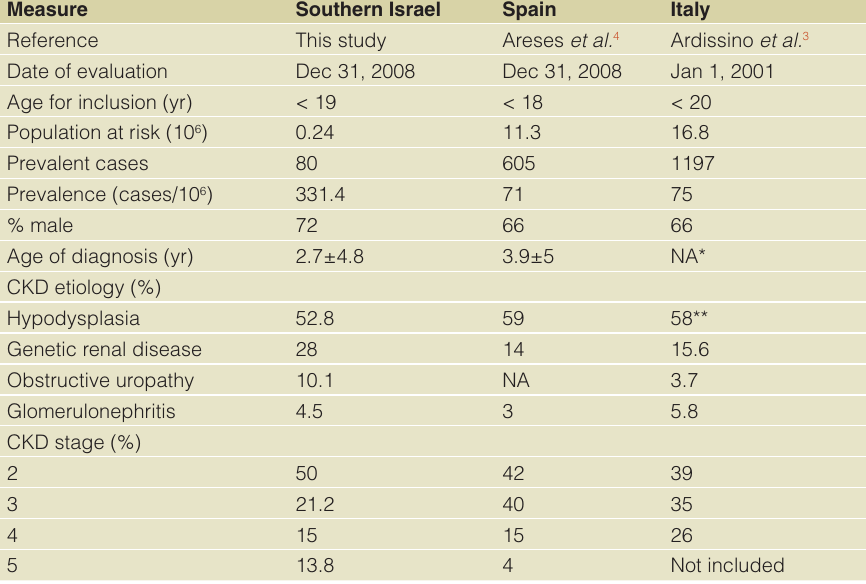
Table 2. Chronic kidney disease (CKD) stage 2–5: comparison with other epidemiological studies. * Age at registration: 6.9±5.4. ** Including congenital obstructive uropathy.